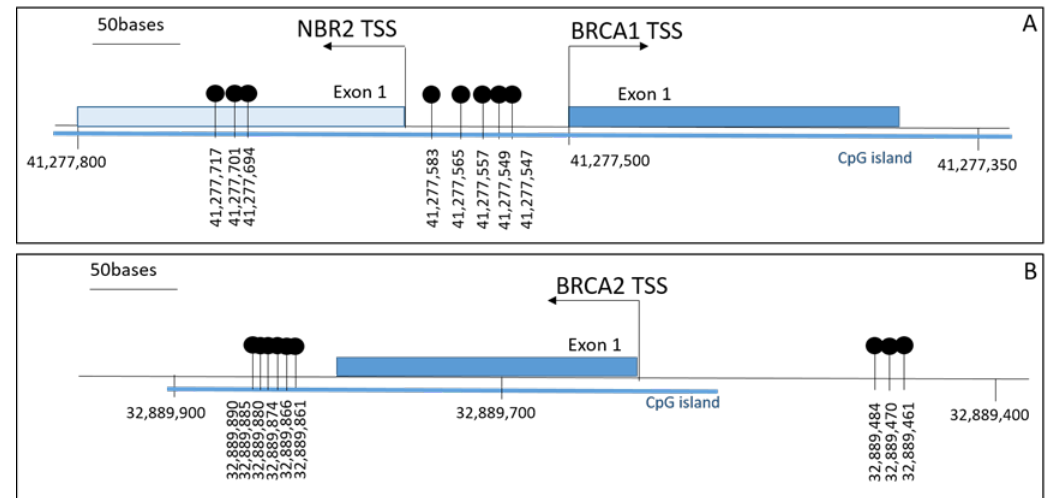
Figure 1. Individual CpG sites investigated in BRCA1 ( A ) and BRCA2 ( B ) promoter. Genomic coordinates correspond to the RefSeq NM_007294, transcript variant 1 ( BRCA1 gene) and NM_000059.3 ( BRCA2 gene), using GChr37/hg19 assembly. TSS: Transcription Start Site.